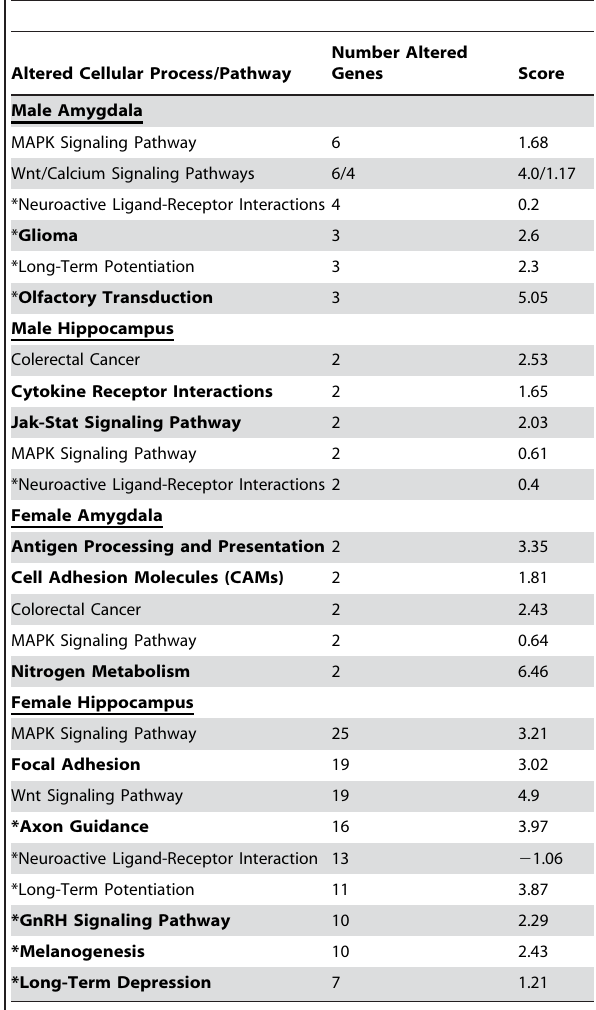
Table 1. Pathways/processes (KEGG) with the greatest number of affected genes along with any neural-pathway/ processes (*) with multiple altered